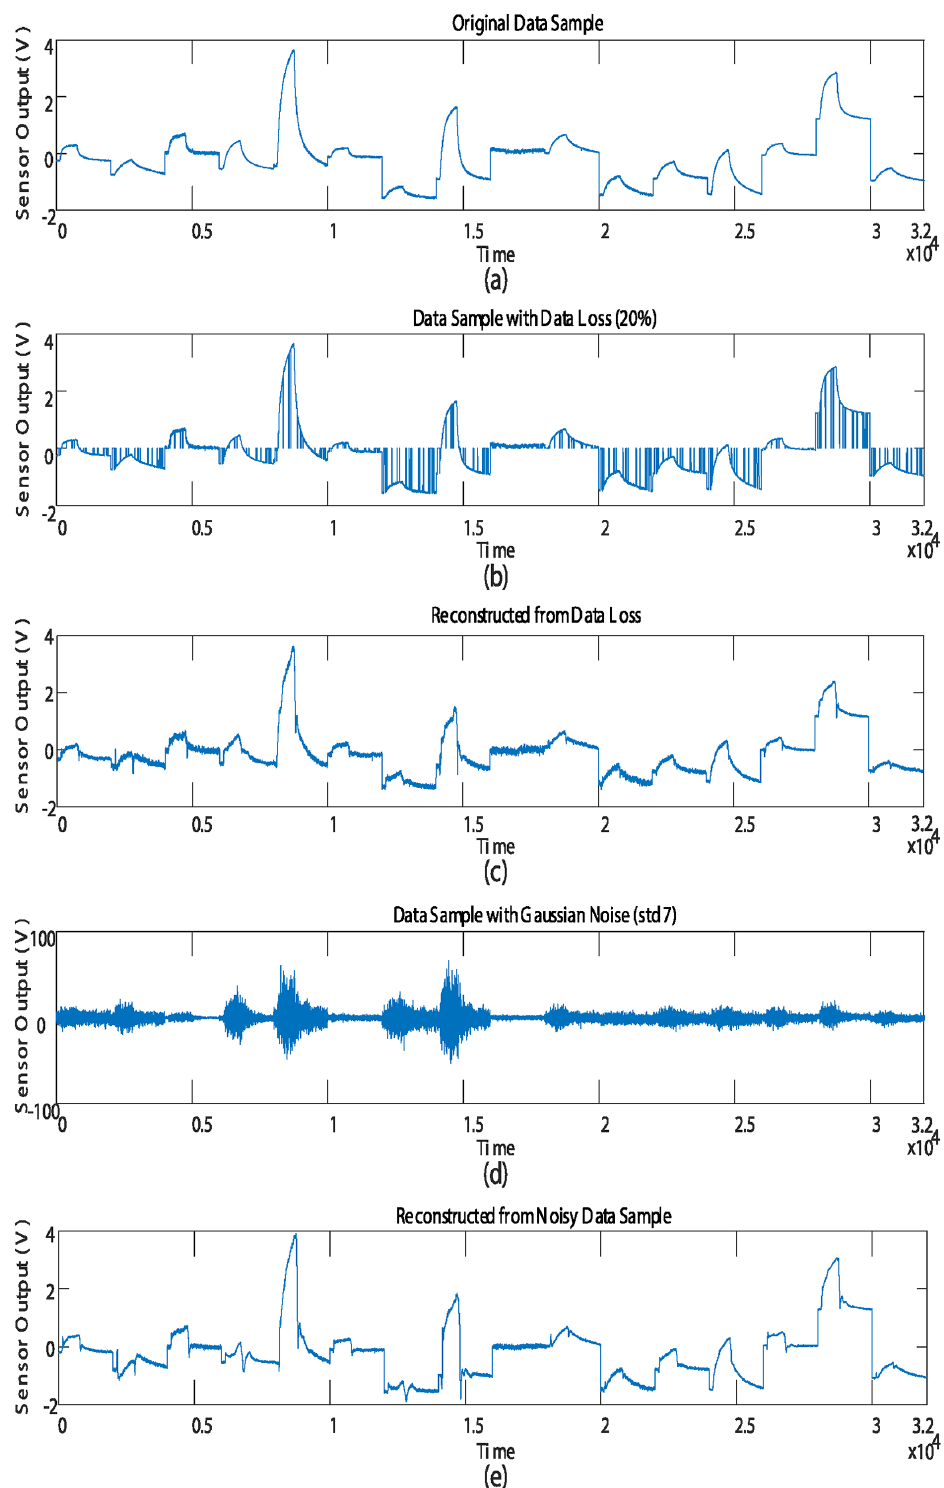
Fig 7. Representation of the data sample before and after the reconstruction process. (a) Original data sample. (b) Data samples with data loss x dmg . (c) Reconstructed data sample from loss x re . (d) Data sample with Gaussian noise x dmg 20% 20% Reconstructed data samples from noise x re . GN